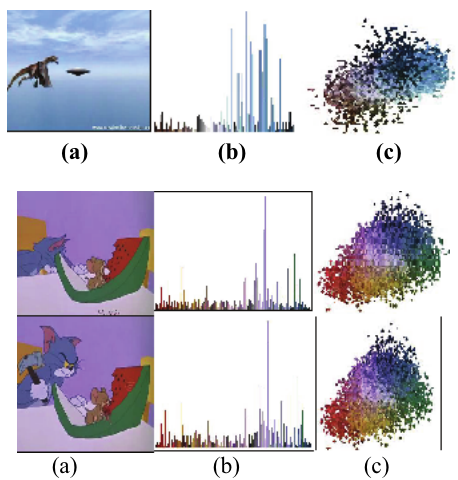
Fig. 5.2. (a) keyframe in RGB colorspace, and their corresponding (b) histogram, (c) 3D color histogram(d) LAB colorspace of keyframe, and their corresponding (e) histogram